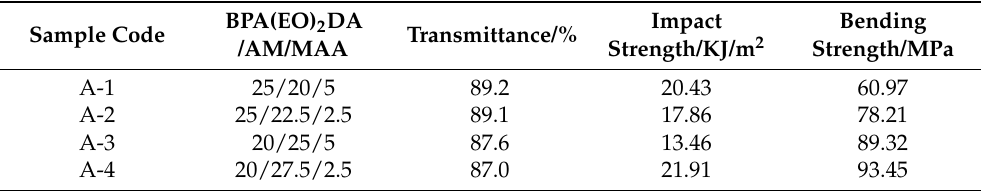
Table 1. The properties of metallized acrylic containing both Gd and